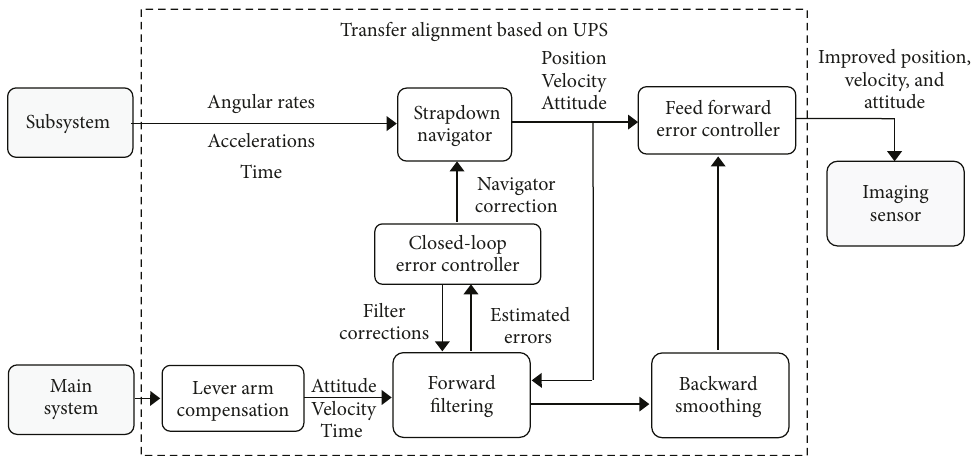
Figure 2: The block diagram of transfer alignment in distributed POS based on